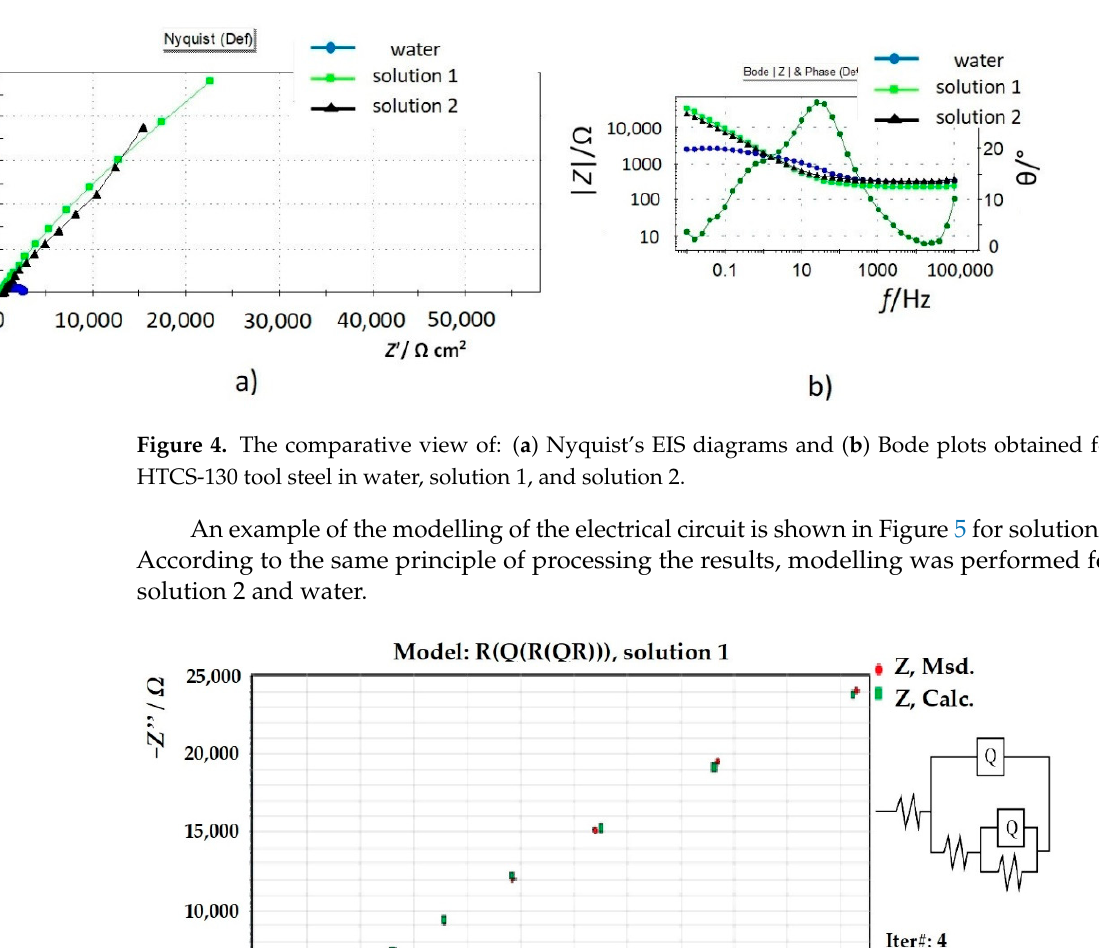
Figure 3. Time dependence of the open circuit potential of HTCS-130 tool steel in water, solution 1, and solution 2.